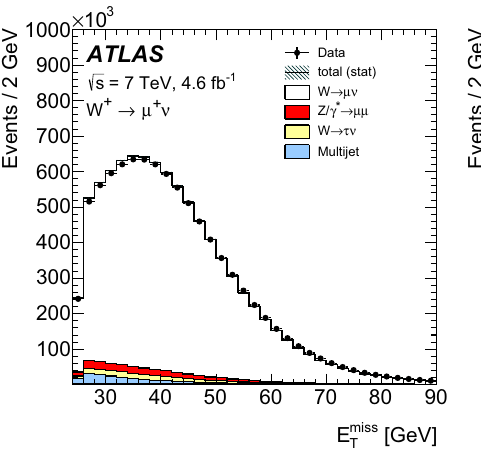
the estimated yield of multijet events. The sum of all expected back- ground and signal contributions is shown as a solid line with a hashed band detailing the statistical uncertainty and labelled “total (stat)”. The legend lists only background sources with a visible contribution